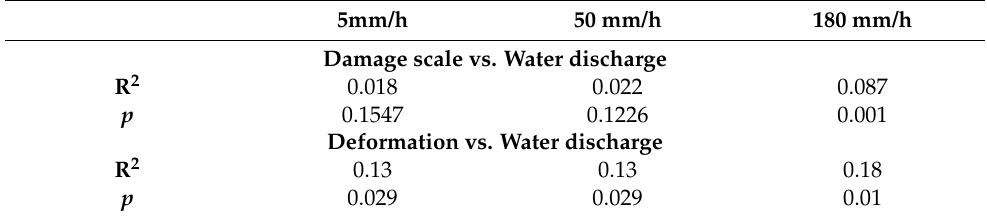
Figure 14. Comparing water discharge rates and dry wall deformations (D f or D b ) for the three precipitation scenarios. Table 4. Statistical analysis of the relationships between the damage scale, the deformation with the water